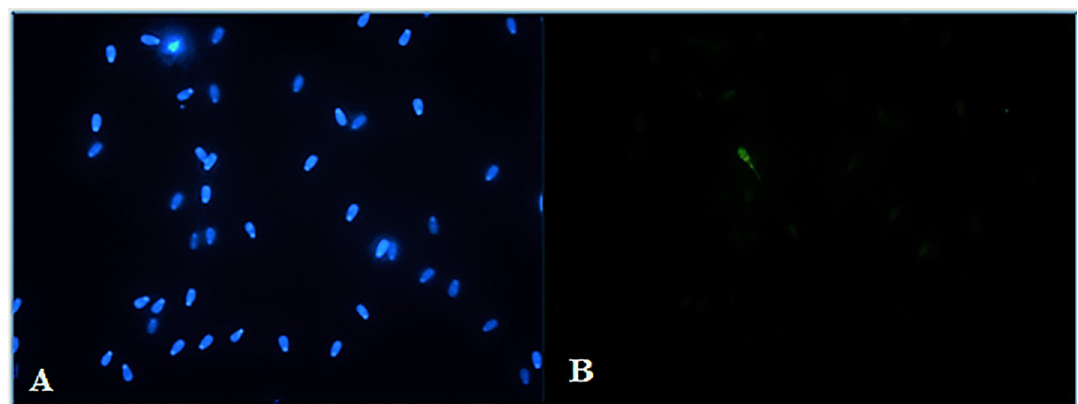
Fig 3. Fluorescent staining of bovine spermatozoa in the control group without FeSO 4 .7H 2 O administration after Time 2 h of culture. Blue-stained (DAPI positive) chromatin of spermatozoa heads (A). The cells are Annexin V-negative (B), without apoptotic changes (400x magnification).